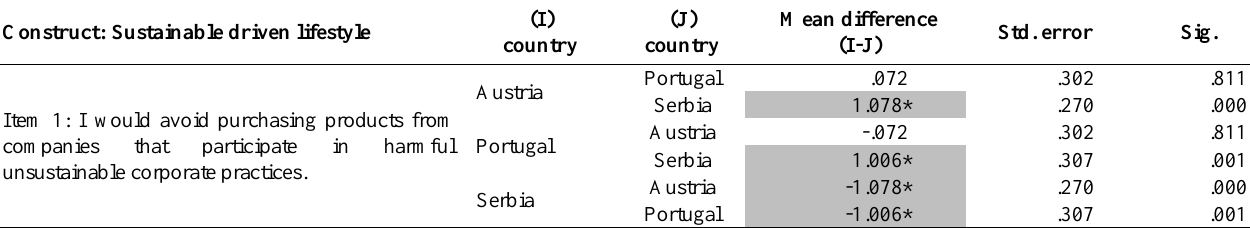
Table 6: Post-hoc test: LSD multiple comparisons